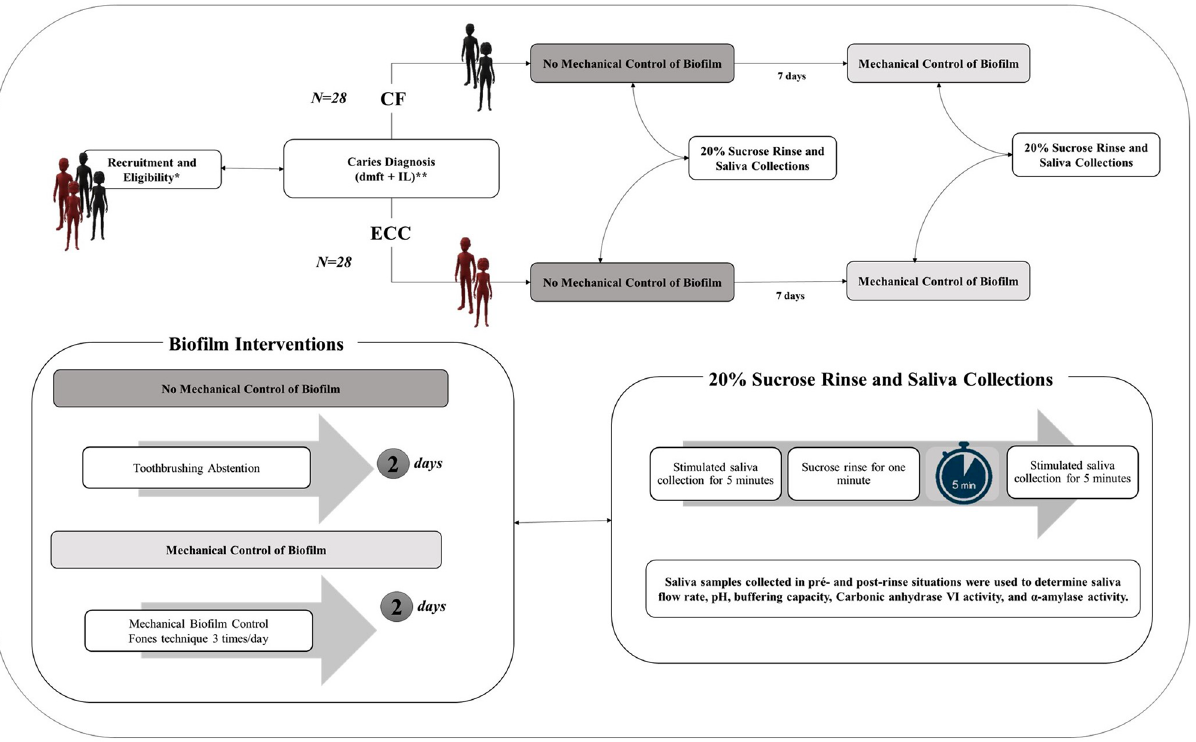
Figure 6. Scheme of the experimental design. During the study, we collected information regarding sucrose intake. * Recruitment and Eligibility: Potentially eligible children who were invited to participate (n = 250) and 170 were excluded because parents refuse to sign the informed consent (n = 128) or the number of confirmed eligible children in each group was completed (n = 42) ⟶ 80 Children were examined for eligibility, from those 24 were excluded because they refused to cooperate (n = 6), had a systemic disease (n = 2), had communication difficulties (n = 1), their parents did not cooperate (n = 10) or the number of confirmed children in their respective group was completed (n = 5). The number of confirmed eligible children were 56 according to the equal allocation in the CF and ECC group. **Caries Diagnosis: Caries diagnosis of each dental surface (dmfs) according to the recommendations by the World Health Organization 41 , along with the diagnosis of initial active caries lesions (IL) 43 . CF = Caries-free: Absence of caries experience and initial active caries lesions. ECC = Early Childhood Caries: Diagnostic thresholds including all visible signs of caries that can be assessed by dmfs plus diagnosis for initial active caries